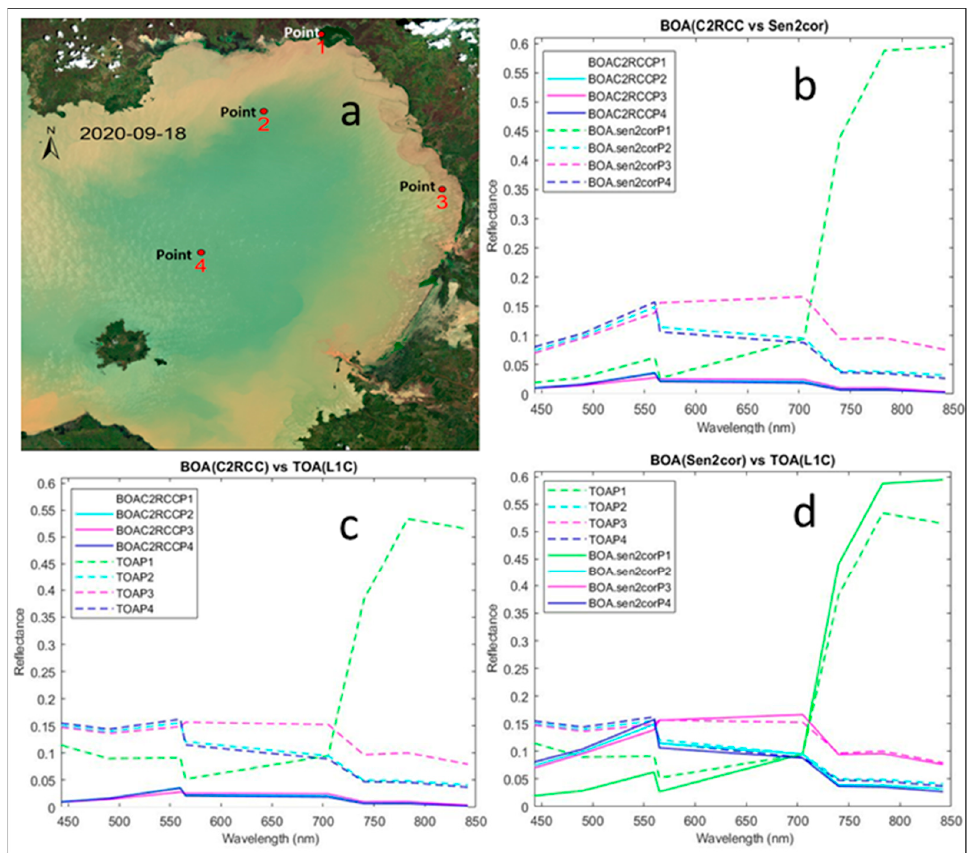
Figure 3. ( a ) Control points (in red) of water hyacinth (P1) and water (P2-P4) from a Sentinel-2 image on 18 September 2020; comparison of values between ( b ) BOA reflectance derived from C2RCC and Sen2Cor, ( c ) level-1C (TOA) reflectance and BOA C2RCC, and ( d ) level-1C (TOA) reflectance and BOA Sen2Cor. There was no water hyacinth reflectance value at P1 from the C2RCC processor, due to masked data considered as